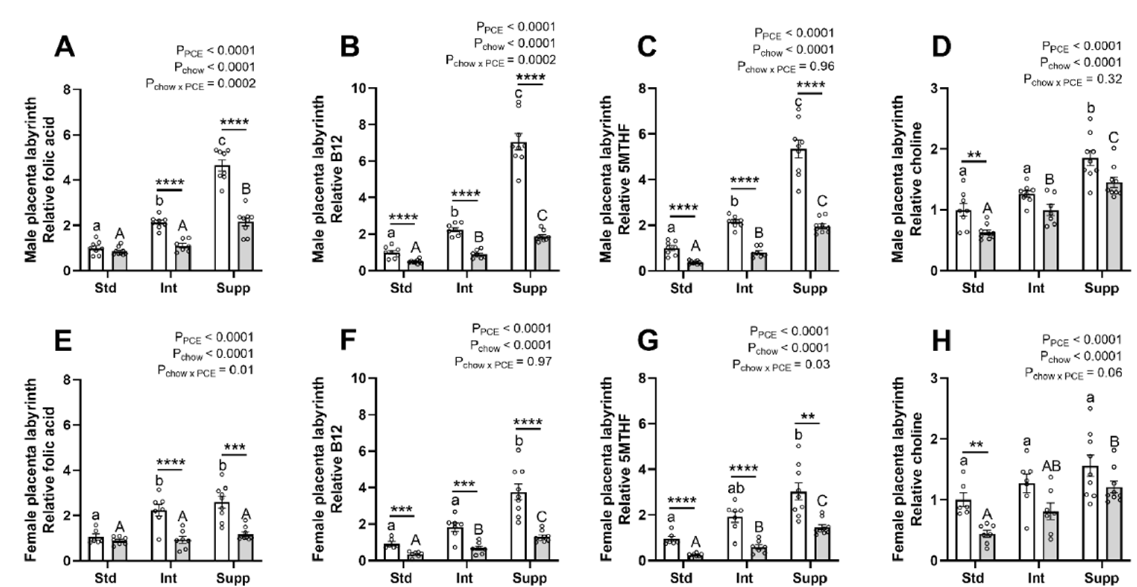
Figure 4. The effects of periconceptional ethanol and maternal choline supplementation on specific components of the folate cycle and choline in placentas of male ( A – D ) and female ( E – H ) fetuses. ( A , E ) folic acid; ( B , F ) vitamin B12; ( C , G ) 5-methyl tetrahydrofolate (5MTHF); and ( D , H ) choline. During the periconceptional period, dams received a control liquid diet (Con; open bars) or a liquid diet containing 12.5% v / v ethanol (PCE; grey bars). For the remainder of pregnancy, dams received either standard chow (Std), intermediate chow (Int), or supplemented chow (Supp), with increasing levels of choline across these groups (1.6 g, 2.6 g, or 7.2 g choline/kg chow), n = 6–9 per group. Molecules were measured using mass spectrometry and data are expressed as fold-change relative to the average of the male Std-Con group (mean ± SEM). Significant differences due to alcohol exposure or chow group were identified by two-way ANOVA and Tukey’s post hoc analysis. ** p < 0.01; *** p < 0.001, and **** p < 0.0001 for differences between Con and PCE within each chow group; chow effects between Con groups are shown by lower-case letters, and between PCE groups by upper-case letters.